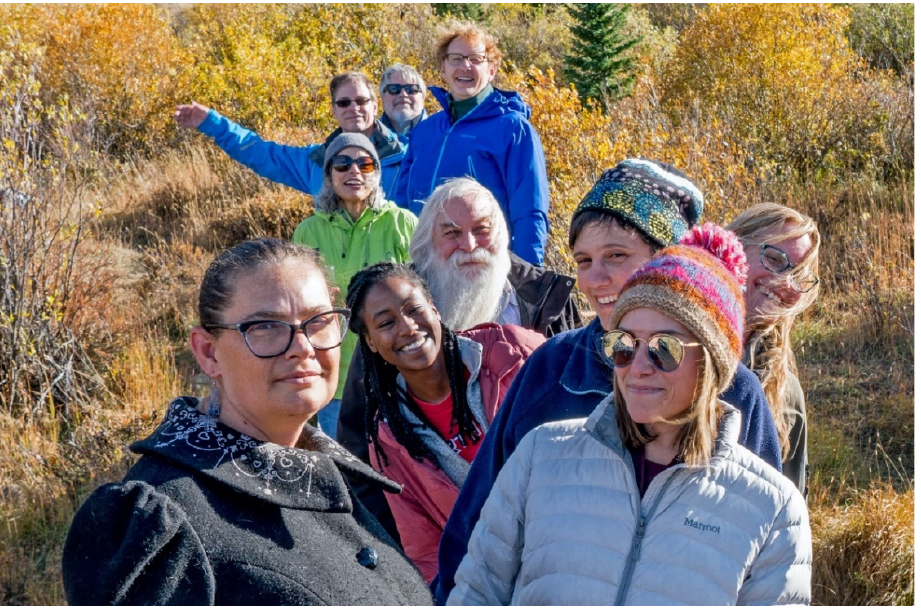
Figure 2. The Rocky Mountain Virology Association meeting in 2019. The photo shows several vi- rologists at the meeting taking a hike in the mountains around the Colorado State University con- ference center during an afternoon recess. Randy, as usual, is at the center of an active discussion along the trail. Besides Randy, those in the picture include Laura Ashton, Carmen Ledesma-Felici- ano, Christie Mayo, Amy MacNeill, Jasmine McCoy, Lee Fortunato, Sven Heinz, Joel Baines and Joel Rovnak. The meeting was held in late September when the golden leaves on the aspen trees are most